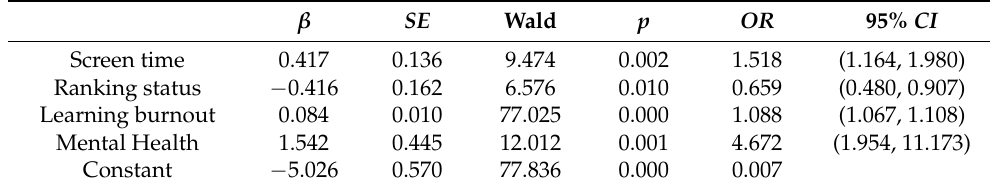
Table 3. Binary Logistic regression analysis of sleep quality of the primary students in grades